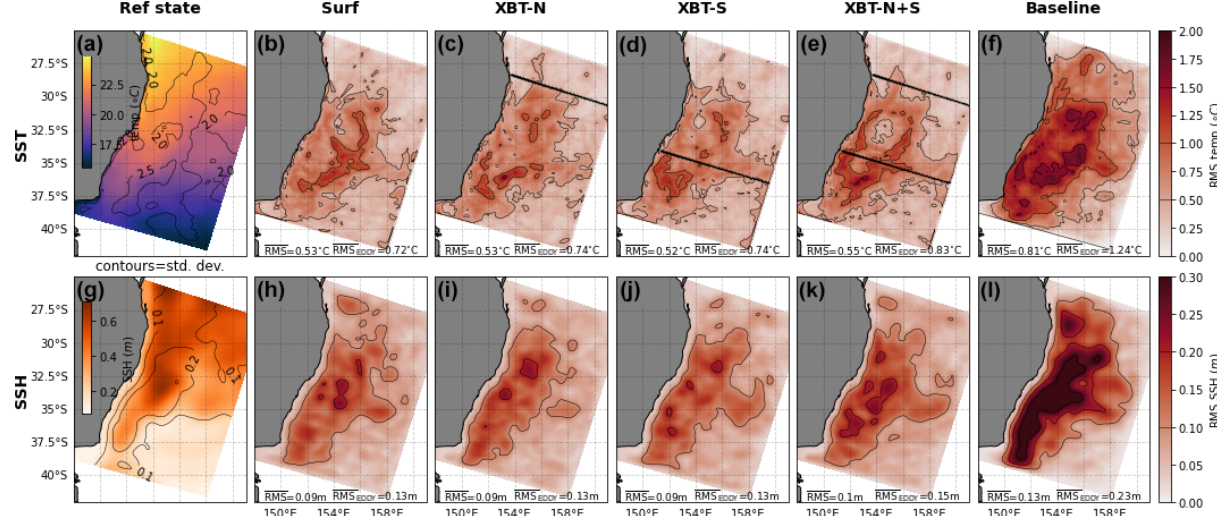
Figure B2. The differences in spatial representation of SSH and SST between the reference state, each OSSE, and the baseline simulation. (a) The mean SSH of the reference state, with contours of standard deviation in that field. The rms error between the reference state and the OSSEs (b) surf, (c) XBT-N, (d) XBT-S, (e) XBT-N+S, and (f) baseline. The second row (panels (f–j) ) shows the same diagnostics for the SST. In reference state panels, contours are the standard deviation in the respective field, while in all OSSE panels, the contours are of rms error. Contour intervals are the same for all panels and are shown as a line in the rms error colour bar. Black lines in panels (c) – (e) indicate location of the XBT lines. The area-mean RMSE and the mean RMSE over the high EKE region in box b (see Fig. 3b) are shown for each OSSE.